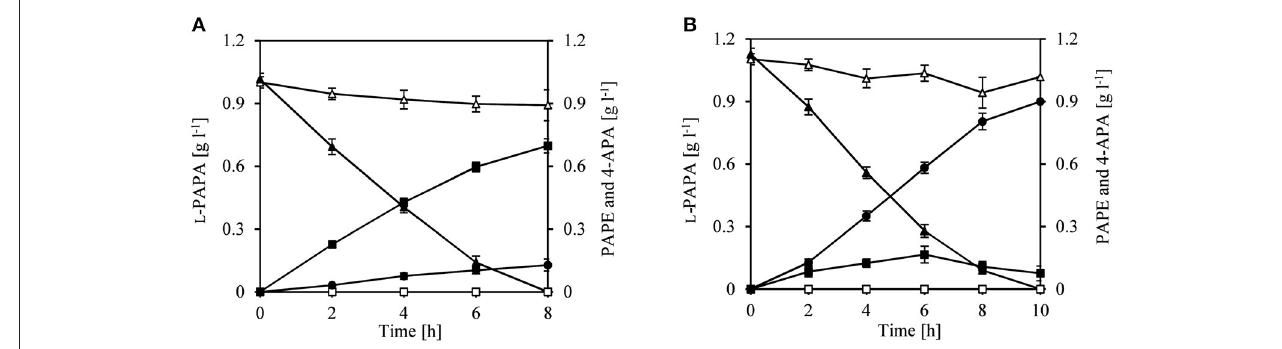
FIGURE 2 | Whole cell biotransformation of para -amino-L-phenylalanine ( L - PAPA) with resting cells of E. coli LJ110/pJFA10 and LJ110/pJFA10F. The Biotransformation was performed at 30 ◦ C on a rotary shake with 110 rpm and an initial L-PAPA concentration of 1–1.1g l − 1 (triangles). Resting cells of E. coli